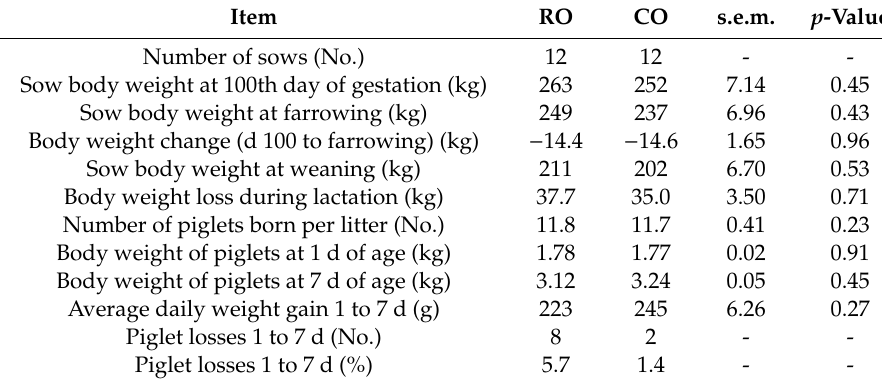
Table 3. Sows reproductive rates.